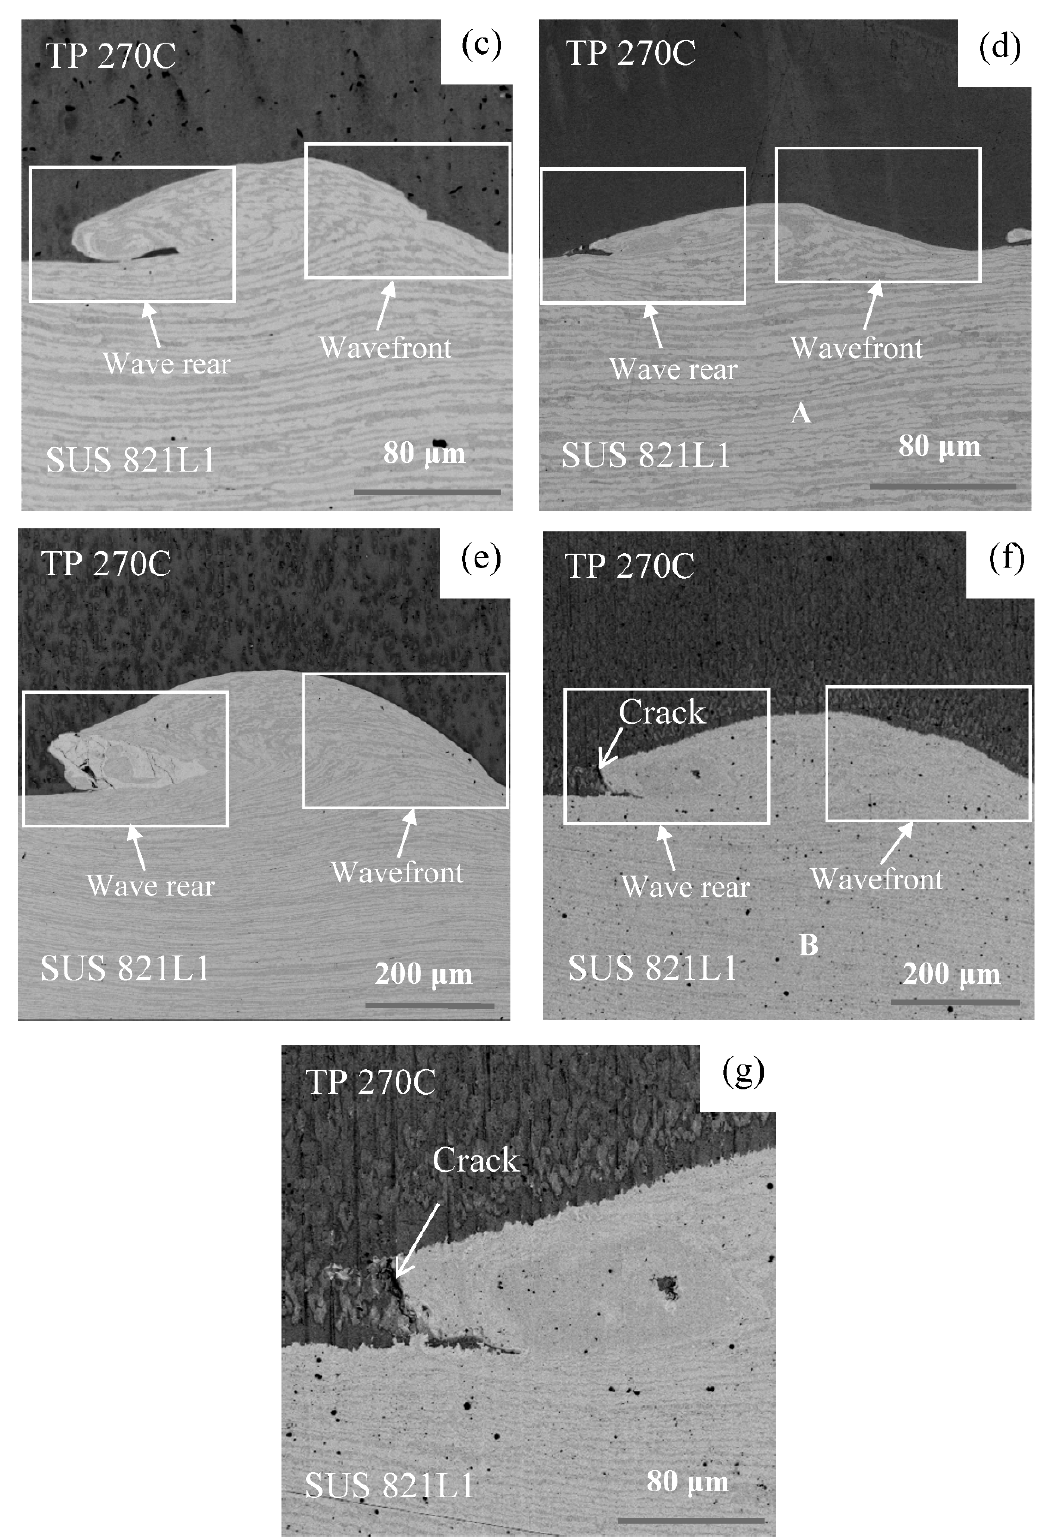
Figure 8. Results of the 90° bending test: ( a , b ) macroscopic results; ( c ) before bending (stand-off = 5 mm); ( d ) after bending (stand-off = 5 mm); ( e ) before bending (stand-off = 15 mm); ( f , g ) after bending (stand-off = 15 mm).